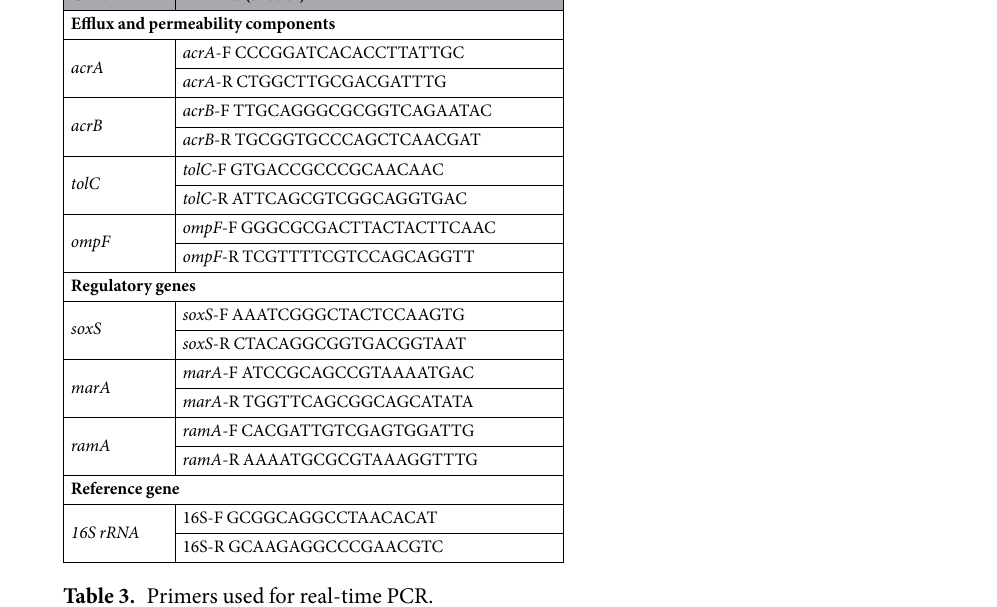
Table 3. Primers used for real-time